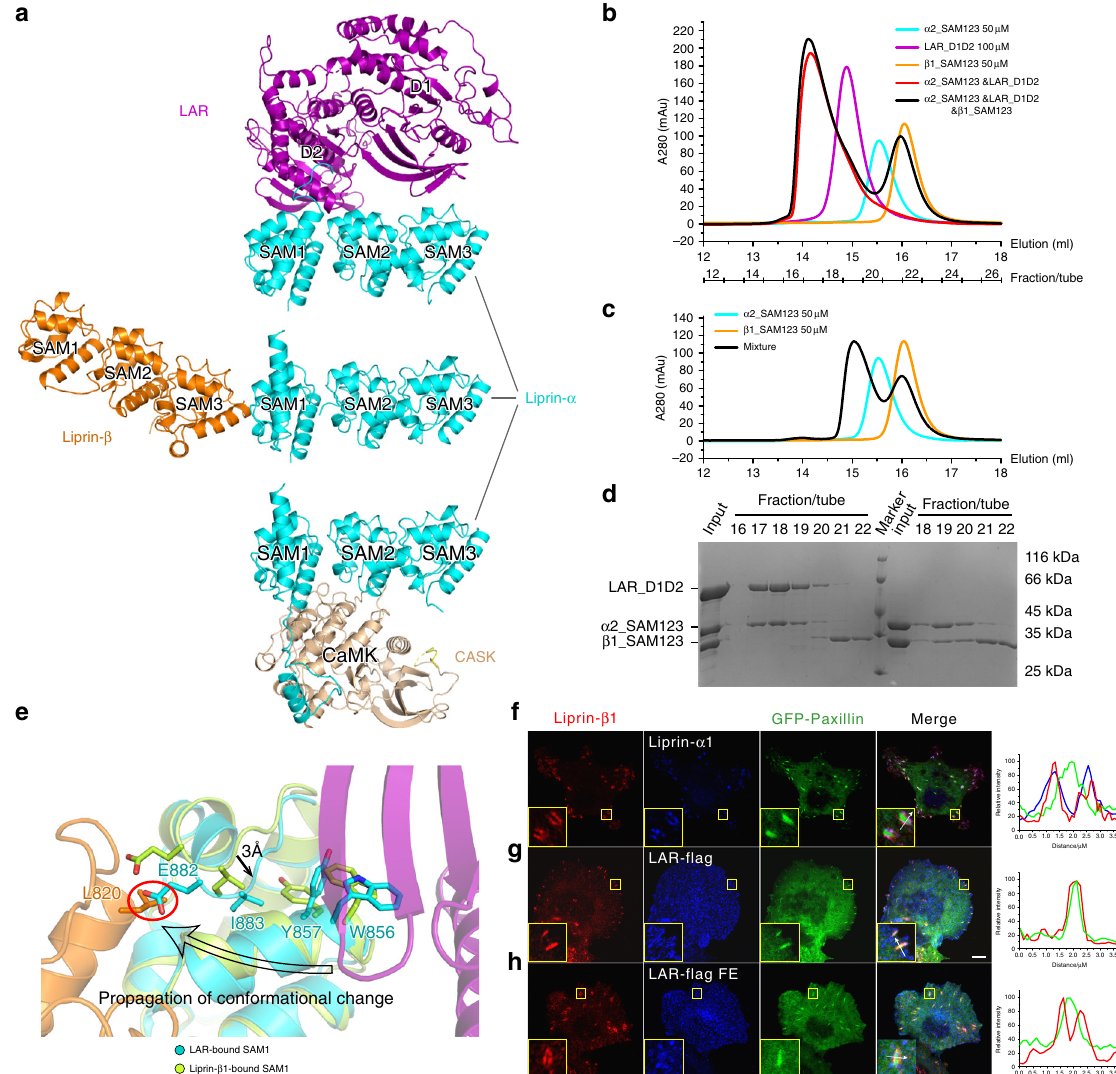
Fig. 6 Allosteric regulation of SAM123-mediated interactions. a Analysis of the different target-binding surfaces on liprin- α _SAM123. The three liprin- α complex structures are presented with liprin- α _SAM123 in the same orientation. b , c Analytical gel fi ltration analysis showing the binding of liprin- α 2_SAM123 to LAR with or without liprin- β 1 ( b ) and to liprin- β 1 ( c ). d SDS-PAGE analysis of the collected gel fi ltration fractions of the α 2_SAM123/ LAR_D1D2/ β 1- α _SAM123 mixture and the α 2_SAM123/ β 1- α _SAM123 mixture as shown in ( b ) and ( c ), respectively. e Structural comparison of the LAR- bound SAM1 and liprin- β 1-bound SAM1. Residues with large conformational or positional changes were shown in stick model. The steric crash between E882 in the LAR-bound SAM1 and L820 in liprin- β 1, the critical liprin- α -binding site, was highlighted by a red circle. f , g Cell imaging analysis of cellular localization of liprin- β 1. Endogenous liprin- α 1 and liprin- β 1 co-localized in the peripheral regions of the focal adhesion (FA), marked by GFP-paxillin ( f ). The localization of endogenous liprin- β 1 was further analyzed in cells transfected with wild-type LAR-Flag ( g ) and its F1829E mutant ( h ). Scale bar, 10 μ m. Regions of interesting were highlighted and enlarged as insets. Results were further con fi rmed by line pro fi le analysis shown on the